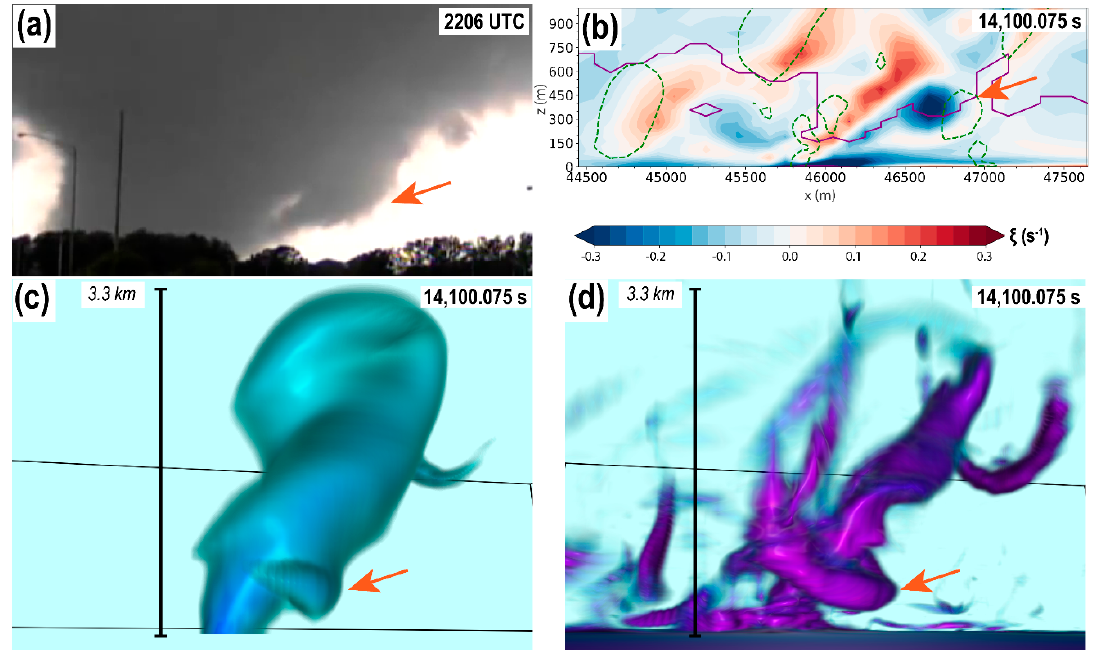
Figure 7. Tilting of HVs in the forward flank of tornadoes. ( a ) Visual observations of the 27 April 2011 Tuscaloosa tornado at 2206 UTC (extracted from Mike Wilhelm’s video, available online at: https://www.youtube.com/watch?v=T0FHTG9VETY; courtesy of M. Wilhelm). ( b ) Vertical cross section of x -vorticity component ( ξ ; shaded in s -1 ) along x = 54.05 km. Solid purple contours denote the 1 × 10 − 3 g kg − 1 cloud water mixing ratio isopleth and dashed green contours denote downward motion regions where w ≤ − 10 m s − 1 . ( c ) DVR of perturbation pressure, highlighting values less than - 9 hPa. ( d ) DVR of vorticity magnitude, highlighting values greater than 0.15 s − 1 (as in Figure 5). The dark orange arrows indicate the position of the HV and the vertical black line indicates the scale height of the tornado in the DVRs. In all panels, the view is from the east-southeast. Tornado motion is due northeast (from left to right in the figure). All simulation fields are valid at 14,100.075 s.